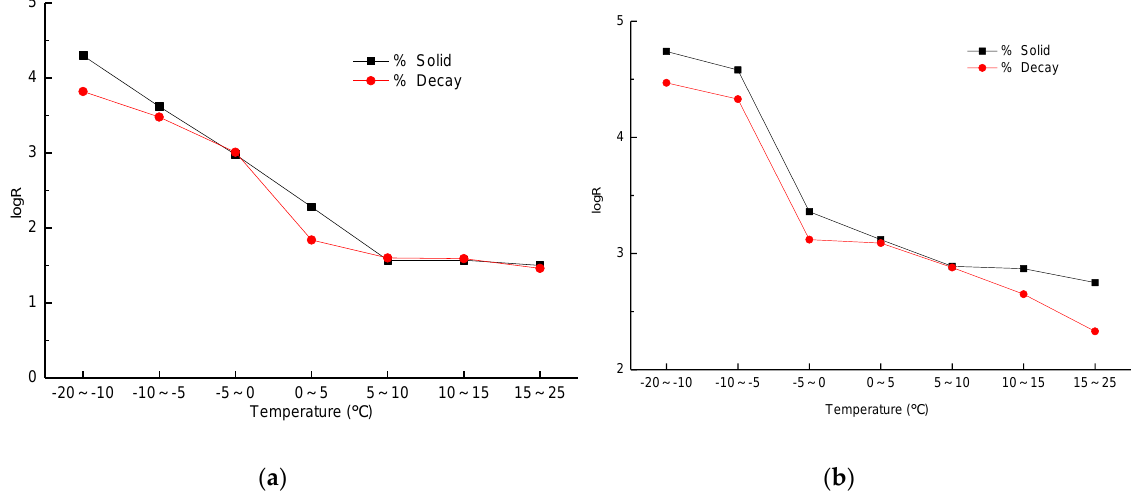
Figure 5. Comparison of the logR in the cross-sections of healthy and decayed trees. ( a ) Populus simonii ; ( b ) Larix gmelinii . ( b ) Larix gmelinii